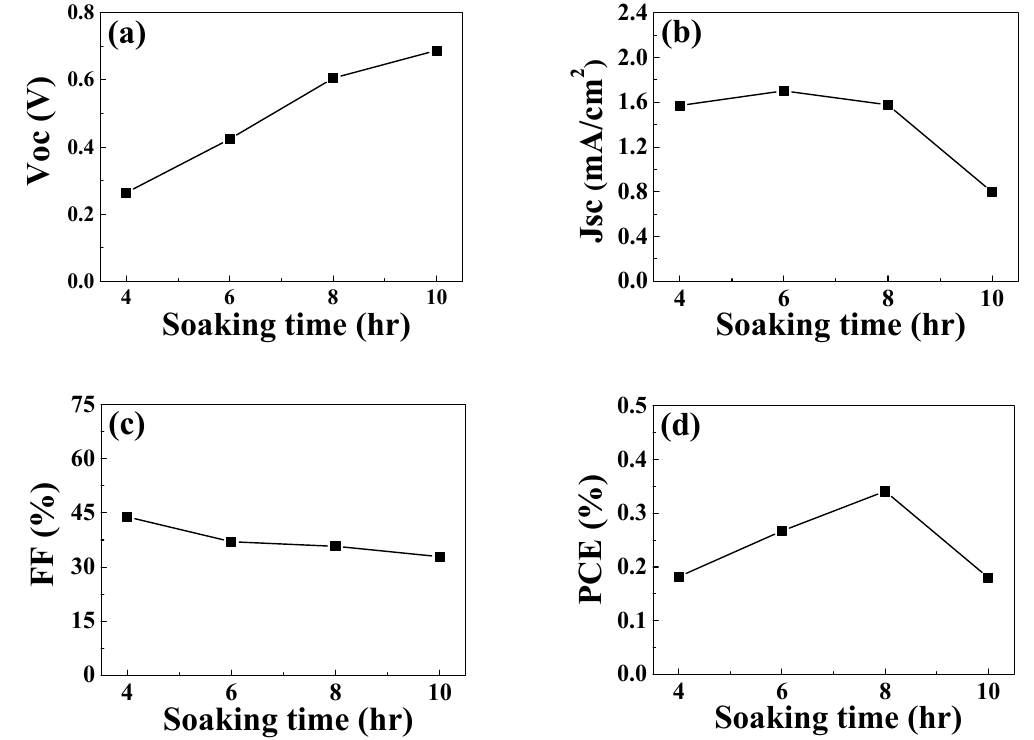
Figure 4. Variation of the photovoltaic performance with growth time: ( a ) J sc , ( b ) V oc , ( c ) Fill factor ( FF ), and ( d ) PCE of the DSSCs measured under AM 1.5 irradiation.